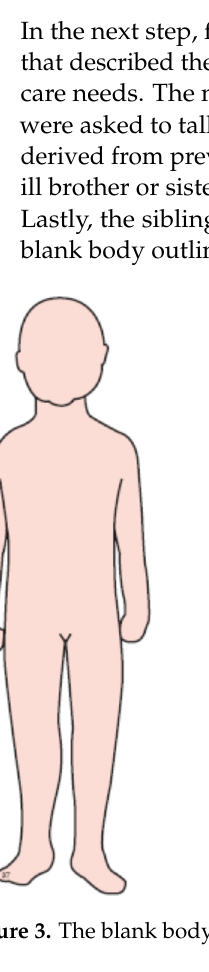
Figure 2. An example of a Bear card [15].